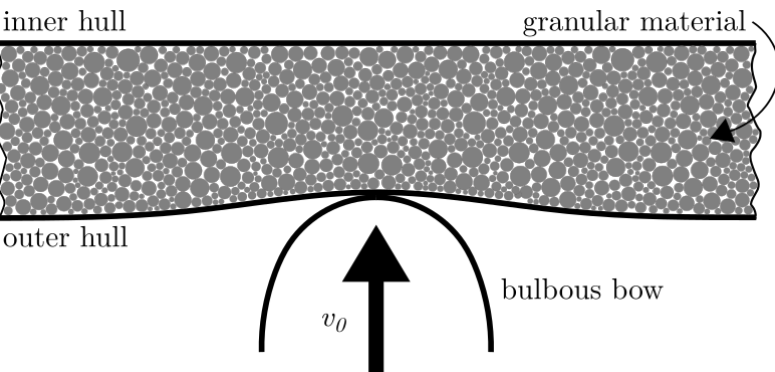
Figure 1. Double-hull filled with a granular